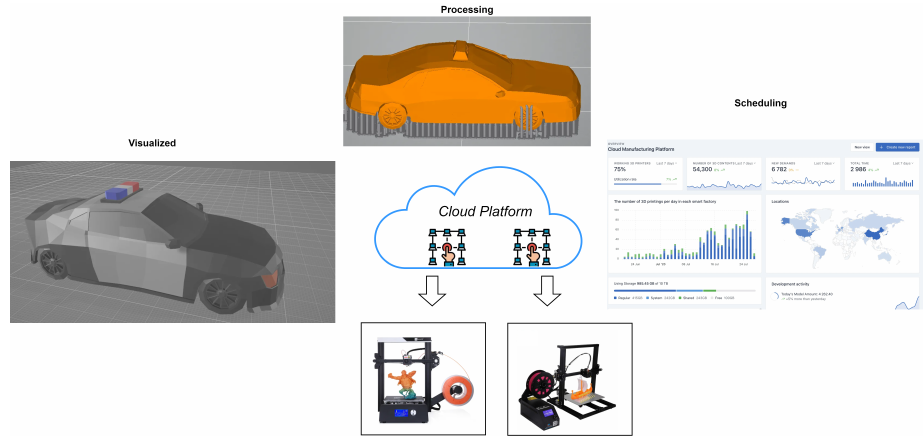
Figure 7. The product customization framework built on a cloud